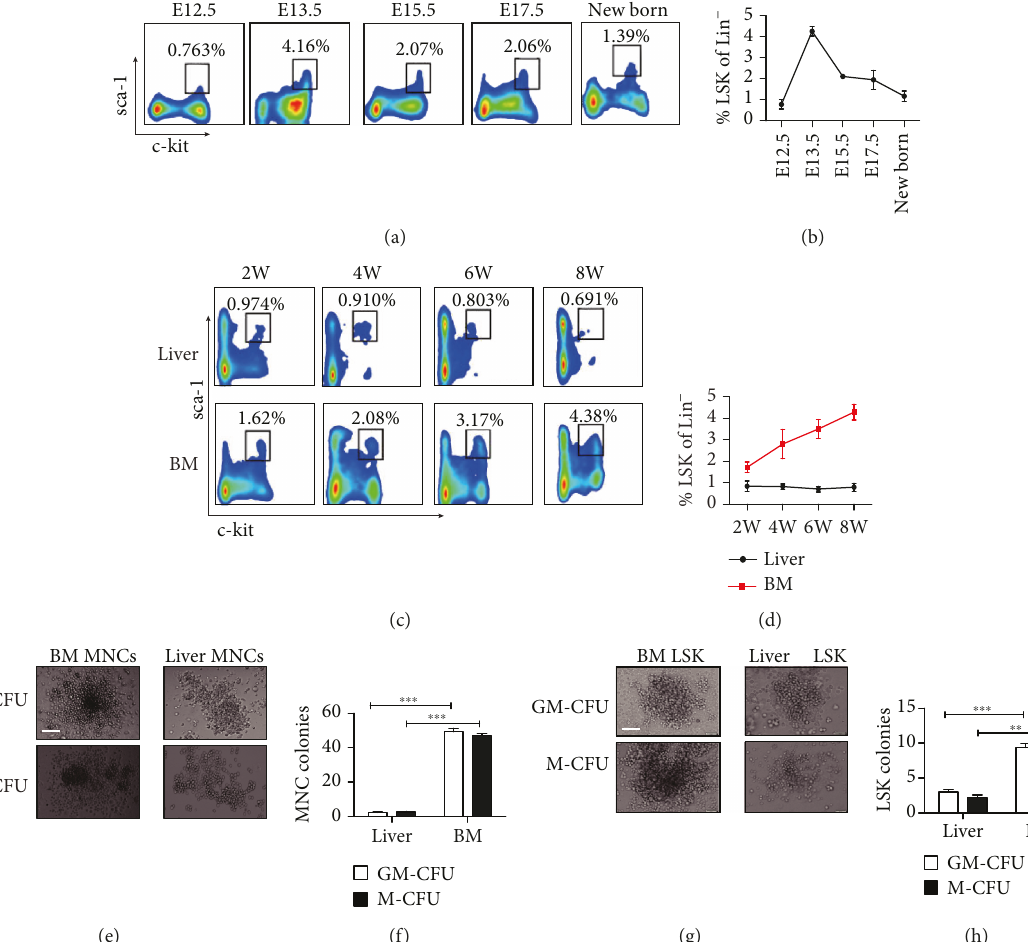
Figure 1: Detection of LSK cells in the di ff erent developmental stages of the liver and bone marrow. (a) The proportion of c-kit + sca-1 + cells in the fl ow plot is gated from the fetal liver and newborn liver Lin - cells ( n = 3 ‐ 6 ). (b) Statistical analysis for the percentage of LSK cells gated from the Lin - cells in the di ff erent developmental stages of the liver. (c) Flow cytometric plots show the percentage of LSKs among the Lin - cells from the bone marrow or liver of young and adult mice ( n = 3 ‐ 6 ). (d) Statistical analysis for the percentage of LSK cells gated from the Lin - cells in the di ff erent developmental stages of the liver and BM. (e, g) Hematopoietic colony formation of the mononuclear cells (e) or LSK cells (g) from the adult liver or bone marrow (the picture shows a single colony in a well of 24-well cell culture plate). A total of 1 × 10 5 bone morrow or liver mononuclear cells was freshly isolated from adult C57BL/6j mice, and 5 × 10 2 bone marrow or liver LSK cells were sorted by FACS and plated into complete methylcellulose medium and incubated for 10 to 14 days. The number of colonies ( ≧ 50 cells are de fi ned as one clone) was counted under an inverted phase contrast microscope. GM- CFU: the added cytokines included SCF, IL-3, FLT-3-L, IL-7, and GM-CSF. M-CFU: the added cytokines included SCF, IL-3, FLT- 3-L, IL-7, and M-CSF. Picture original magni fi cation: × 20 (e, g). Bar: 200 μ m. (f, h) Statistical analysis for the number of GM-CFU and M-CFU from MNCs or LSK cells of BM and liver ( n = 3 ). All colonies were counted in a well of 24-well cell culture plate. Bars represent the mean ± SEM of three independent experiments. ∗∗ P < 0 01 ; ∗∗∗ P < 0 001